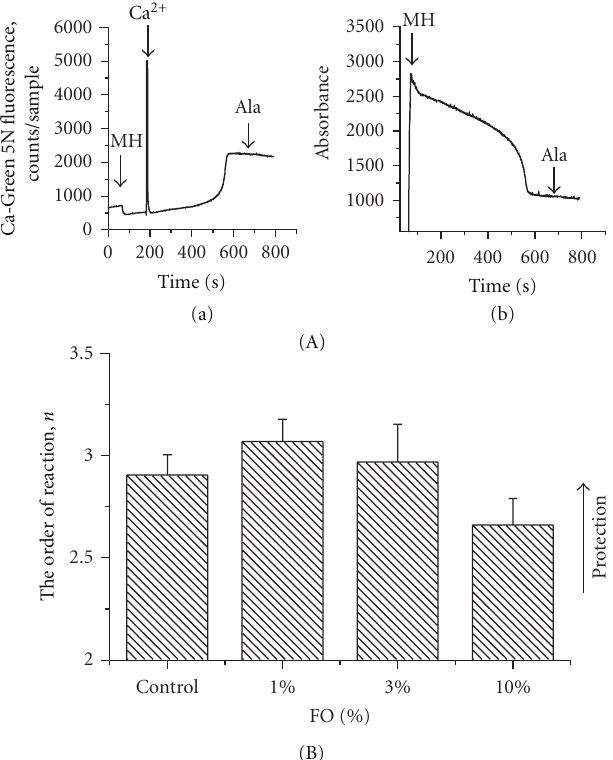
Figure 7: Dependence of kinetic parameter n (order of reaction) on dietary omega-3 PUFA content. (A) An ability of isolated from control animals liver mitochondria to uptake/release Ca 2+ (section (a)) and swell (section (b)) in the presence of Ca 2+ (10 μ M), succinate + rotenone used as a substrate. (B) The order of reaction n was calculated from our kinetic model of Ca 2+ -induced mitochondrial dysfunction for each tested diet. In the framework of the model (see description in text), a change in n reflects a change in the number of Ca 2+ in respect to the MPT induction. Therefore, any change in n would be expected to correlate with an ability of mitochondria to resist to the Ca 2+ -induced swelling. The data are expressed as mean ± SEM, n = 3. Statistical significance of the di ff erences in n between tested samples was determined by a two-sample t